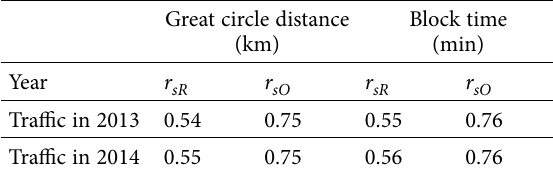
Table 2. Correlation of real and calculated market shares Great circle distance